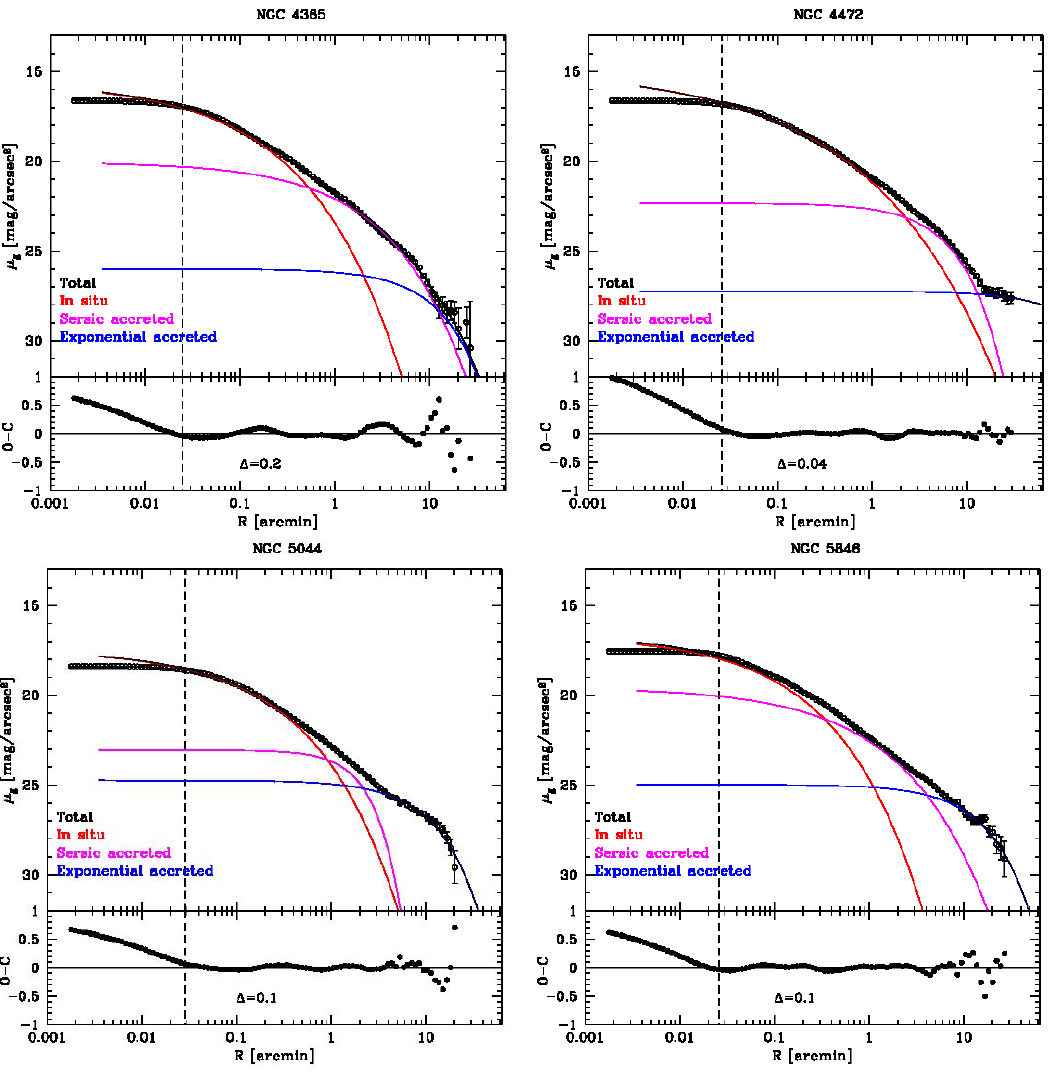
Figure 2. VST g band profiles of NGC 1399, NGC 3923, NGC 4365, NGC 4472, NGC 5044, and NGC 5846, fitted with a three-component model motivated by the predictions of theoretical